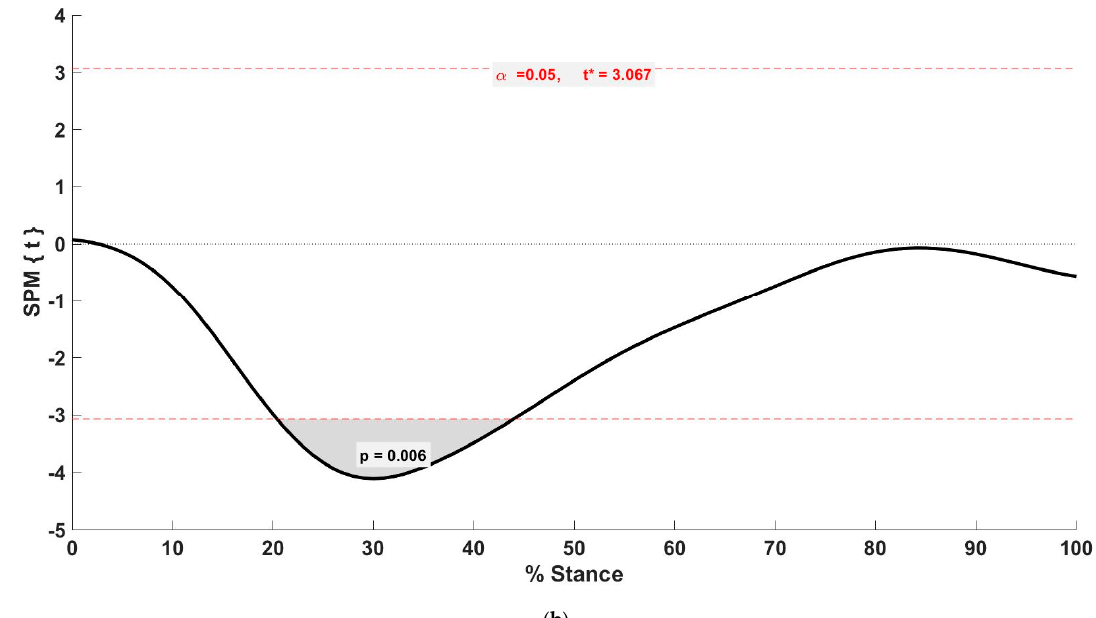
Figure 2. ( a ) Mean (solid line) and standard deviation (shaded) of the frontal plane rearfoot angle between preferred (black), +5% (red), and +10% (blue) step rate conditions. ( b ) t -values of SPM post hoc comparison between preferred and +10% conditions for frontal plane rearfoot angle. Dashed red lines indicate critical threshold ( α = 0.05). Gray shaded area indicates regions with statistically significant differences between the preferred and +10% condition. dition between 2.6% and 34.9% of stance ( p < 0.001) compared with the preferred condi- tion, and significantly reduced in the +10% condition between 6.1% and 31.4% of stance ( p = 0.0059) compared with the +5% condition (Figure 3).